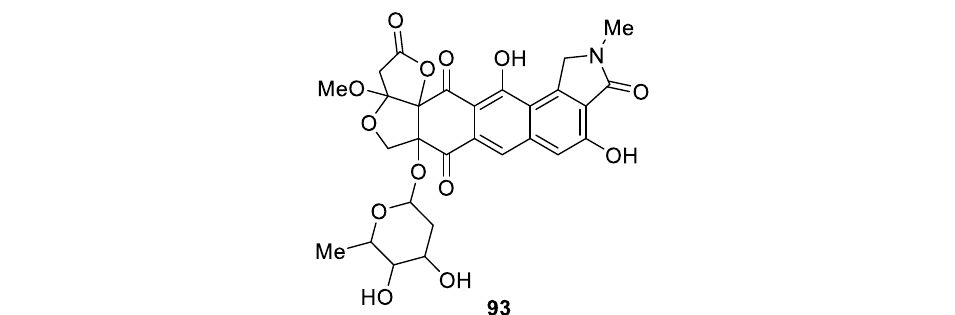
Figure 39. Abyssomycins from Actinobacteria.